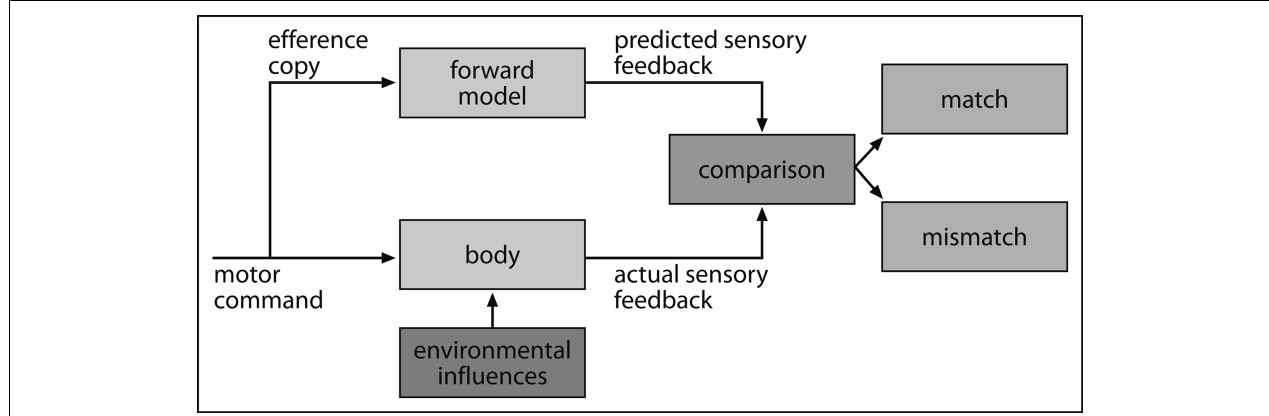
FIGURE 3 | Prediction in motor control. Based on the efference copy of the motor command, a forward model is formulated and used for predicting the consequences of one’s own actions. These predictions are compared with the incoming sensory input which can result either in a “match” in case predictions were correctly formulated, or a “mismatch”, signaling an error in